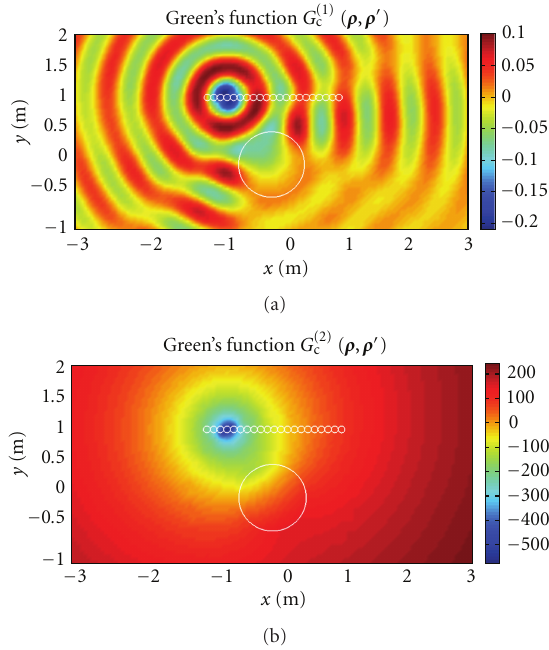
Figure 1: Illustration of measurement setup and Green’s functions G (1) ( ρ , ρ (cid:3) ) and G (2) ( ρ , ρ (cid:3) ) in electromagnetic and electrical resistive c c tomography, respectively. The large circle in the center indicates the tunnel of radius a = 0 . 5m, and the 21 small circles the horizontal sensors (point sources). In both plots shown above, the source is at ρ (cid:3) corresponding to the fourth sensor from the left.